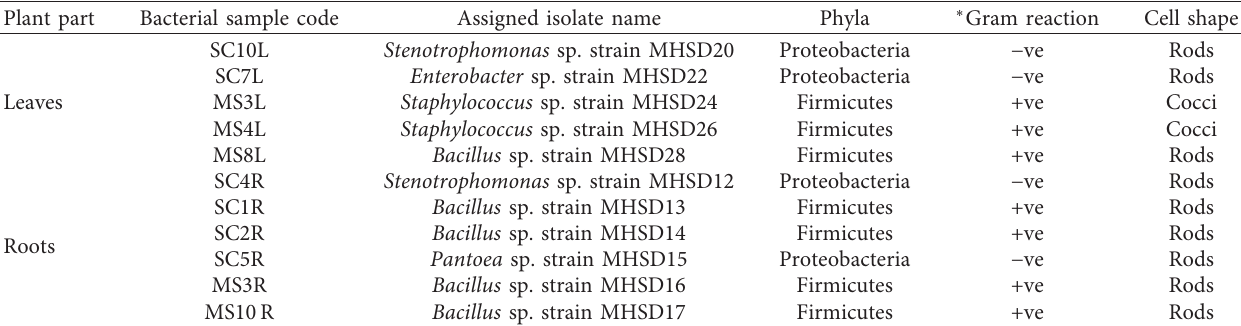
Table 1: Morphological characteristics of bacterial endophytes isolated from leaves and roots tissues of Dicoma anomala . Plant